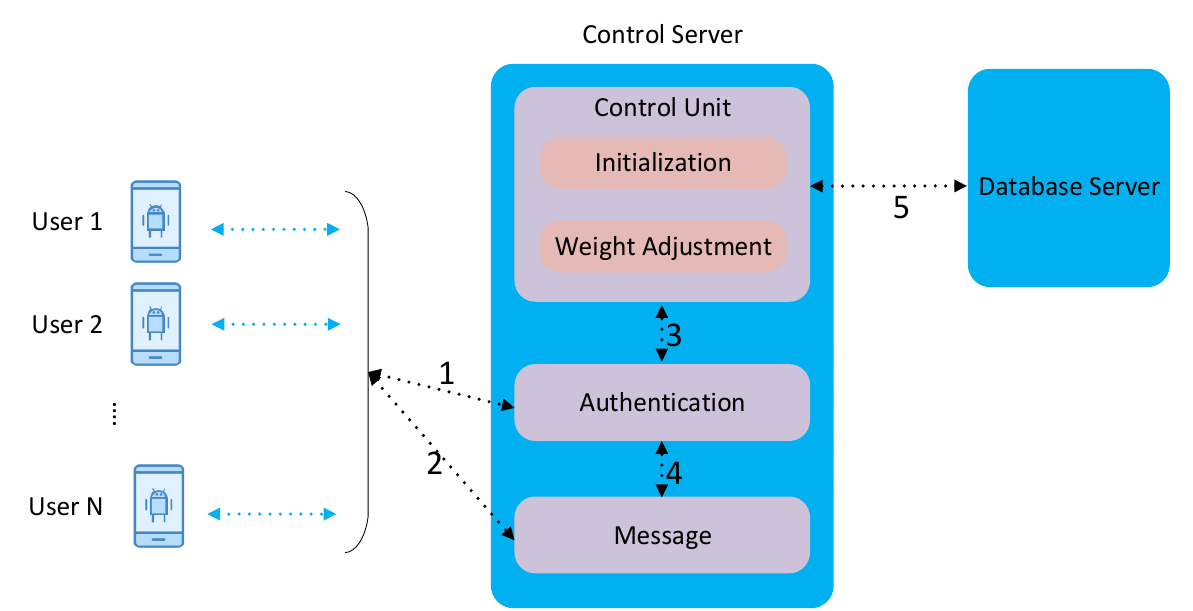
Figure 2. The system architecture of EchoIA. Data flow: 1. Implicit authentication is achieved by comparing current users’ data with their historical data. IA will lock the device and asks users to input passwords if it fails to identify the current user. 2. The system utilizes the inputted passwords to adjust personal features. It will request users’ PINs to update weights for F top and personal features by exchanging messages with legitimate users. 3. Feature’ weights are initialized and used to authenticate users. 4. After inputting a correct PIN, users can update F top . 5. Users can reinitialize the system when inputting a correct PIN. 6. The Control Unit will